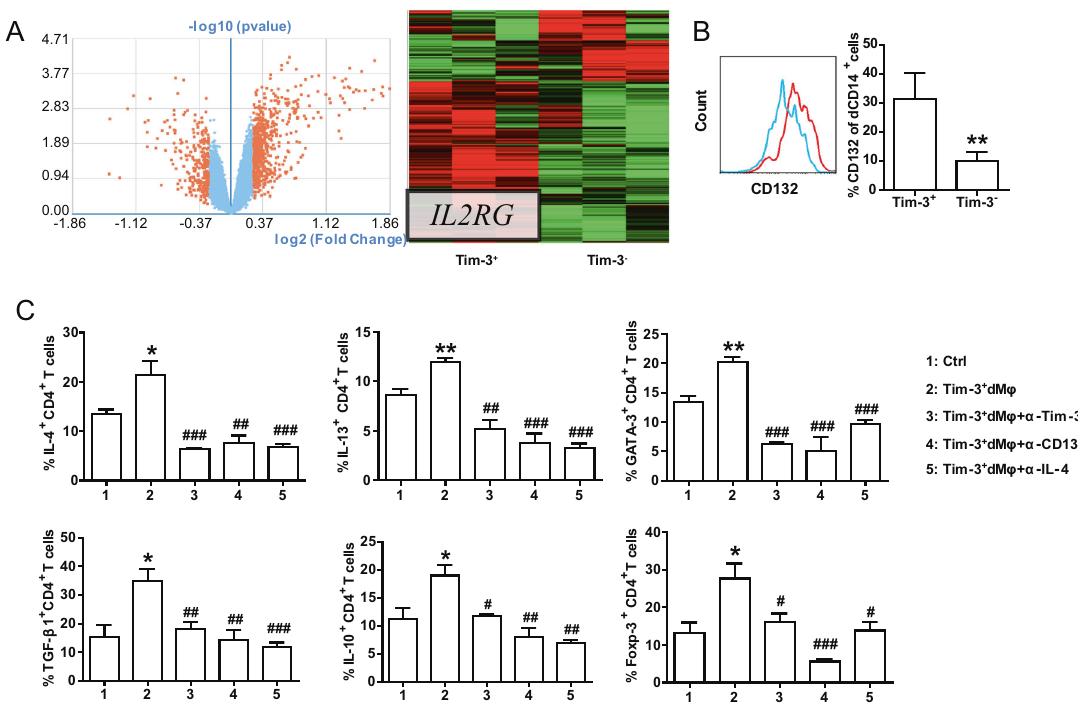
Fig. 5 Tim-3 + dM φ s and Tim-3 − dM φ s showed distinct CD132 expression indicative of different functional regulation on dCD4 + T cells. A The volcano plot and cluster analysis heat map of the differential mRNAs between Tim-3 + dM φ s and Tim-3 − dM φ s form human normal early pregnancy. Volcano plot based on fold change and p value of genes from the unique signatures of Tim-3 + dM φ s and Tim-3 − dM φ s in comparison with each other. Red dots mark the genes with signi fi cantly increased or decreased expression. Heatmap result of an unsupervised hierarchical clustering of genes that is signi fi cantly different in Tim-3 + dM φ s samples compared with Tim-3 − dM φ s samples. For example, gene encoding IL2RG was overexpressed in the Tim-3 + dM φ s population as compared with the Tim-3 − dM φ s. B Flow cytometric analysis and quanti fi cation of CD132 (the protein product of IL2RG gene) by human Tim-3 + dM φ s and Tim-3 − dM φ s ( n = 9). ** p < 0.01, compared with group of Tim-3 + dM φ s. The fl ow cytometry plots are representative of three independent experiments. C Flow cytometric analysis and quanti fi cation of Th2- and Treg-related cytokine expression by human dCD4 + T cells co-cultured with Tim-3 + dM φ s in the present or absence of anti-Tim-3 antibody, anti-CD132 antibody, or anti-IL-4 antibody. Data represent the mean ±SEM. * p < 0.05, ** p < 0.01, compared with the control group. # p < 0.5, ## p < 0.01, ### p < 0.001, compared with the group of Tim-3 + dM φ